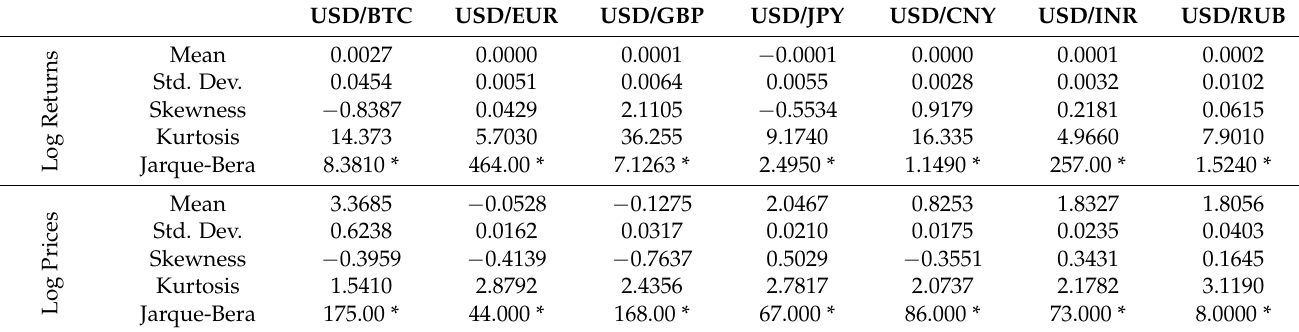
Table 1. Descriptive